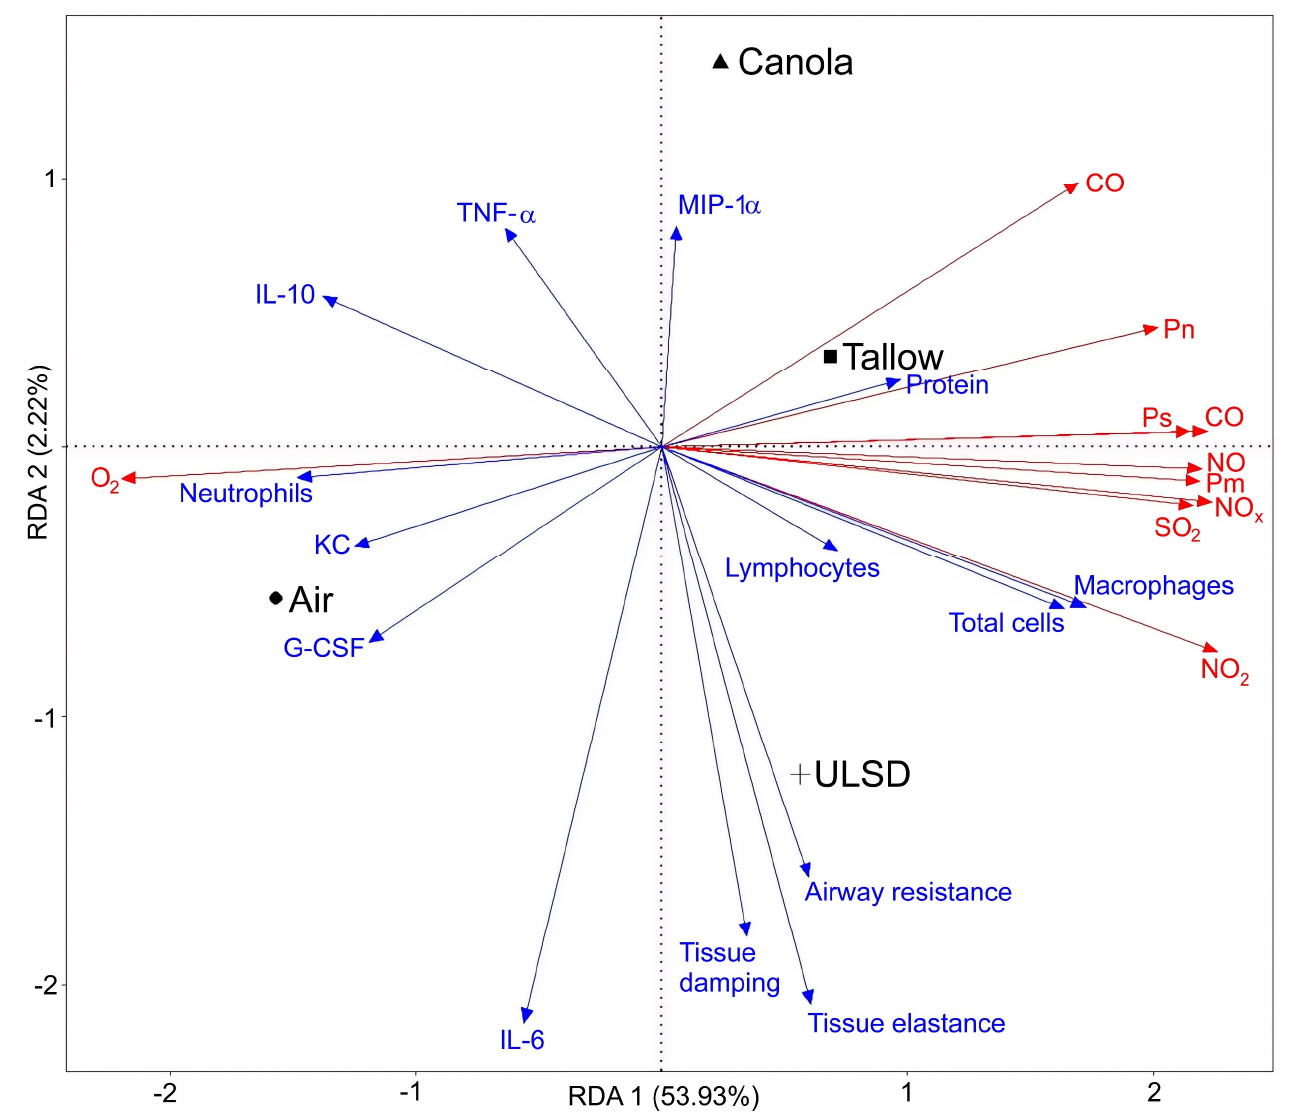
Figure 8. Redundancy analysis model plot showing correlations between exhaust components and important toxicological endpoints. The percentages for each axis are the proportion of variability explained by that axis for the entire dataset; thus, for this model, movement along the x -axis has a greater importance than movement along the y -axis. Exhaust variables are in red, toxicological outcomes are in blue. Arrows that point in the same or opposite directions are highly correlated (positively or negatively, respectively), whereas arrows that point perpendicularly indicate little or no correlation between parameters. Note: Pn = particle number, Ps = particle size, Pm = particle mass.